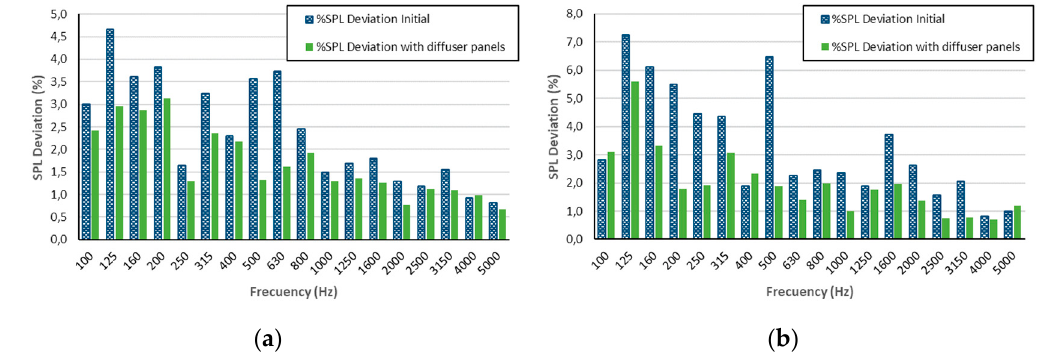
Figure 3. Sound pressure level (SPL) deviation for source and receiving rooms: ( a ) source room; ( b ) receiving room.